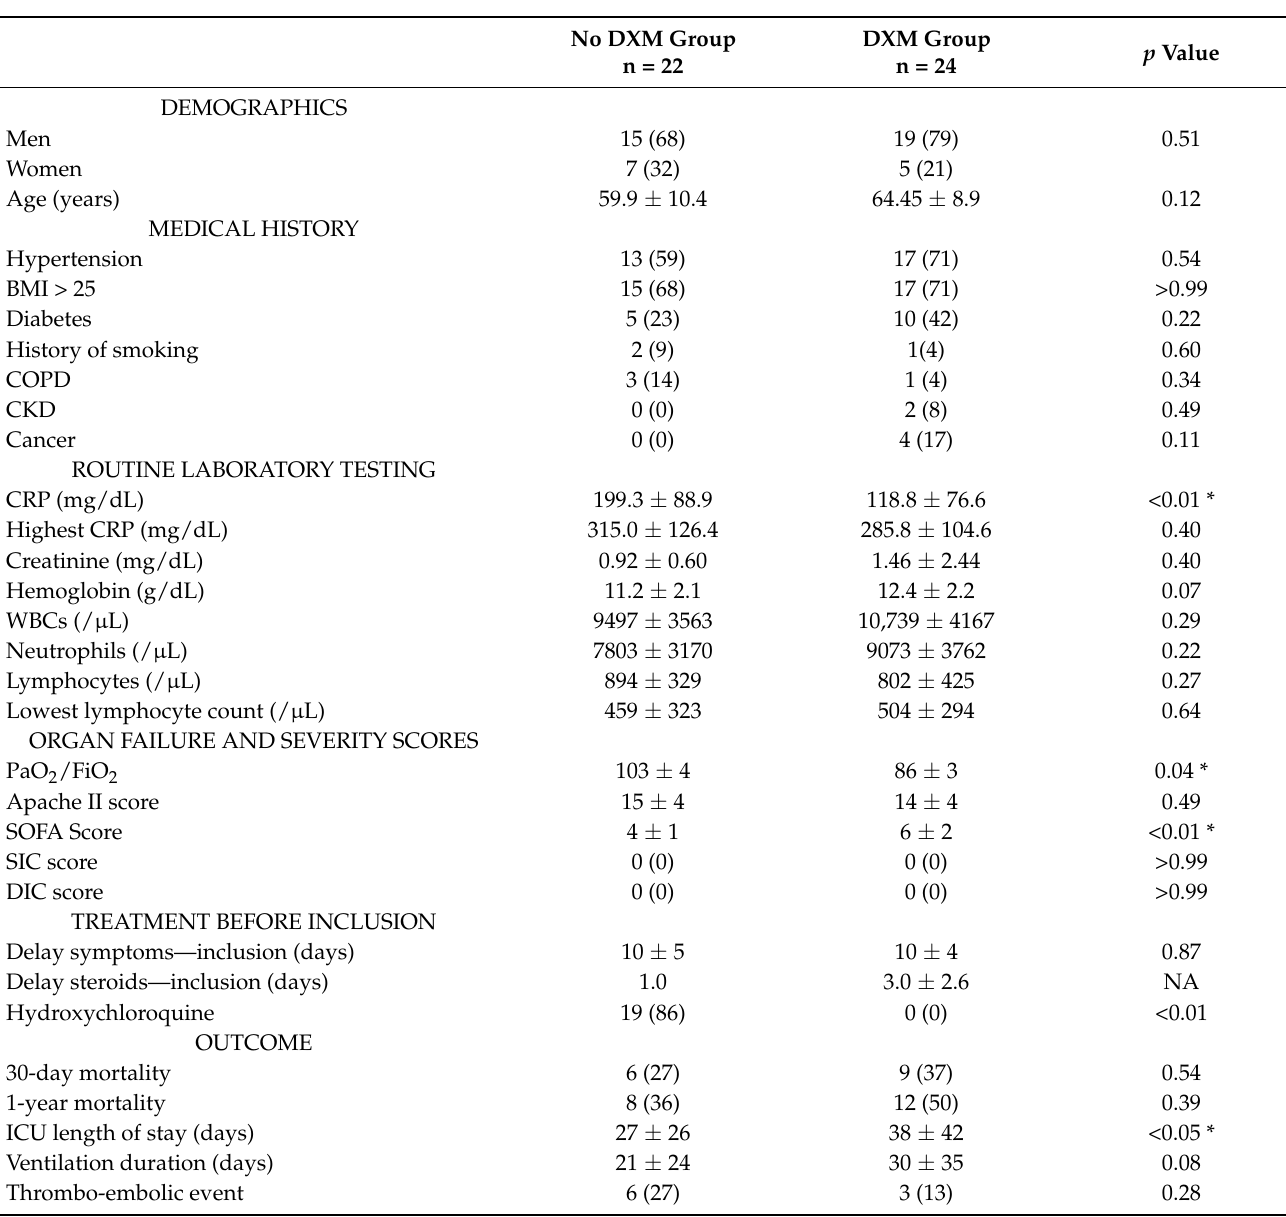
Table 1. Baseline characteristics and clinical outcomes of patients treated or not with